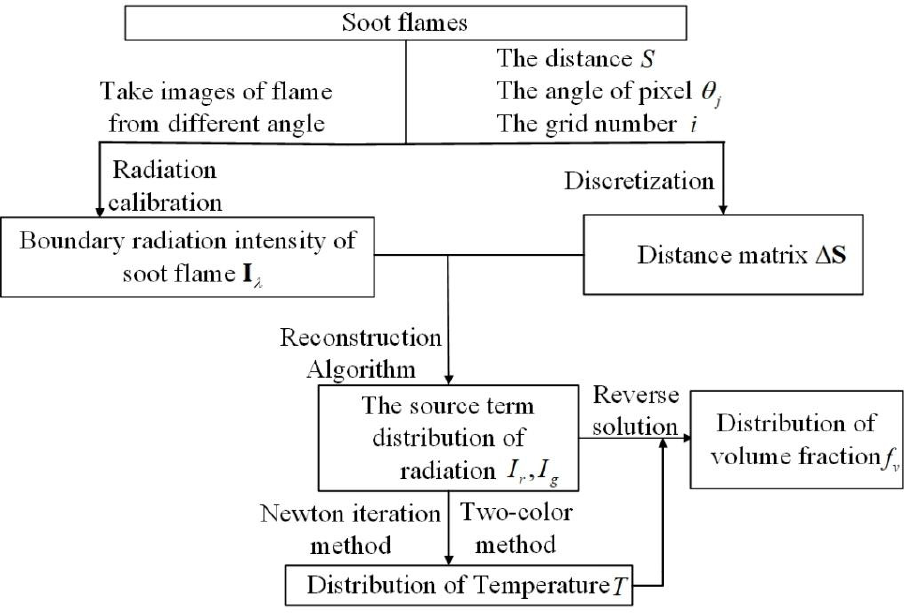
Figure 2. The overall calculation process.